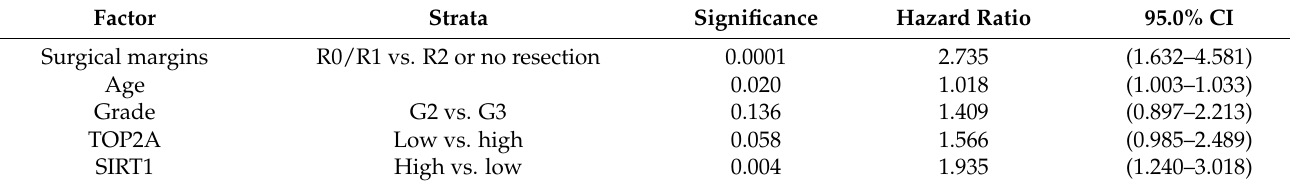
Table 3. Multivariate analysis of overall survival 1. A Cox proportional hazards model for overall survival was calculated, including our biomarkers TOP2A and SIRT1 and statistically significant clinical parameters.